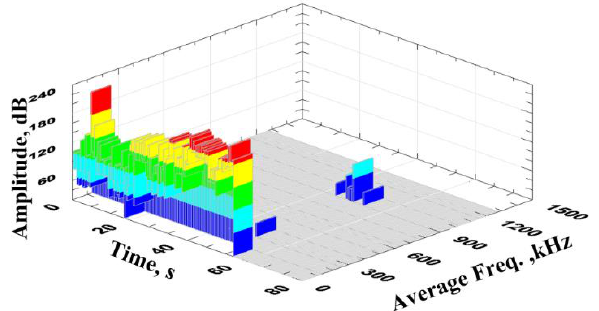
Figure 8 . Amplitude and average frequency change as a function of time